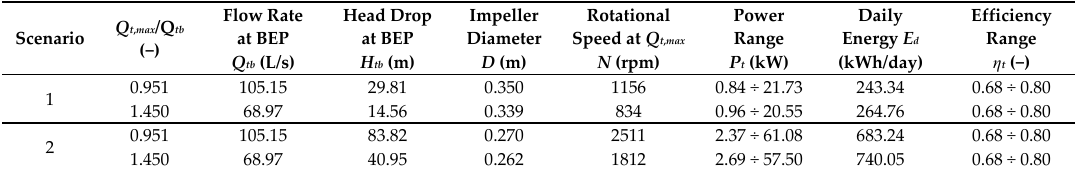
Table 1. PAT design parameters as a function of Q t , max /Q tb ratio— Scenario 1 and Scenario 2 .